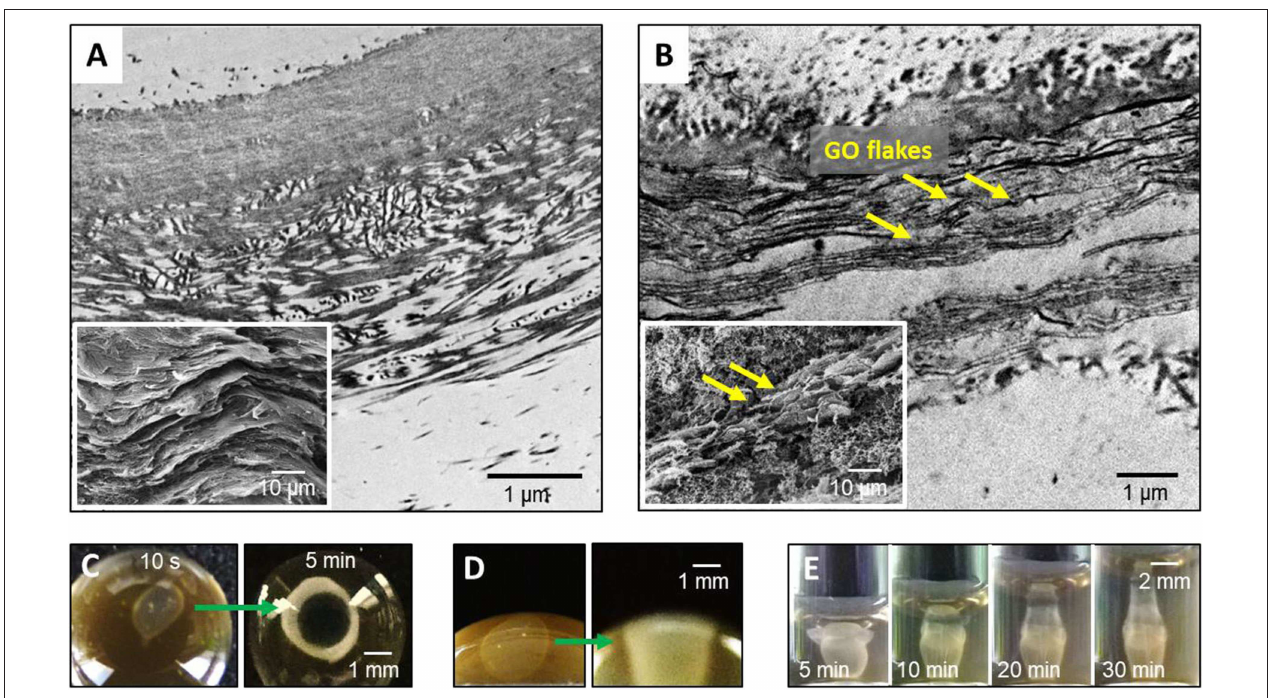
FIGURE 4 | Investigation of GO incorporation and ELR5/PAK3/GO membrane properties. (A) TEM micrograph of a cross-section of an ELR5/PAK3 membrane (Inset is a representative SEM micrograph). (B) TEM micrograph of a cross-section of an ELR5/PAK3/GO membrane with GO flakes (yellow arrows) (Inset is a representative SEM micrograph). (C–E) Demonstration of the dynamic properties of the ELR5/PAK3/GO system including spontaneous opening after a drop of PAK3/GO solution is inoculated into an ELR5/GO solution (C–E) capacity for longitudinal growth upon increasing the ELR5/GO